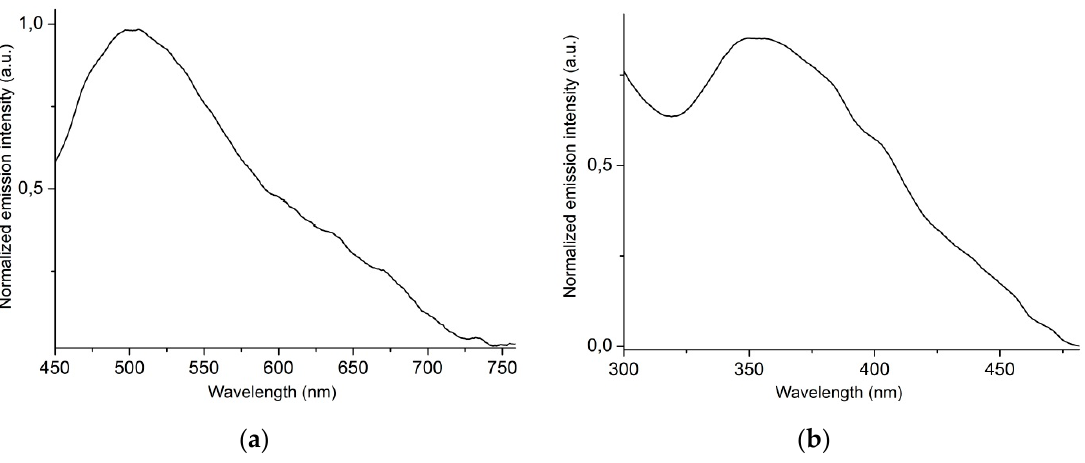
Figure 8. Emission spectrum of the complex 2 in solid state after excitation at 430 nm ( a ). Excitation spectrum at 500 nm emission wavelength ( b ).